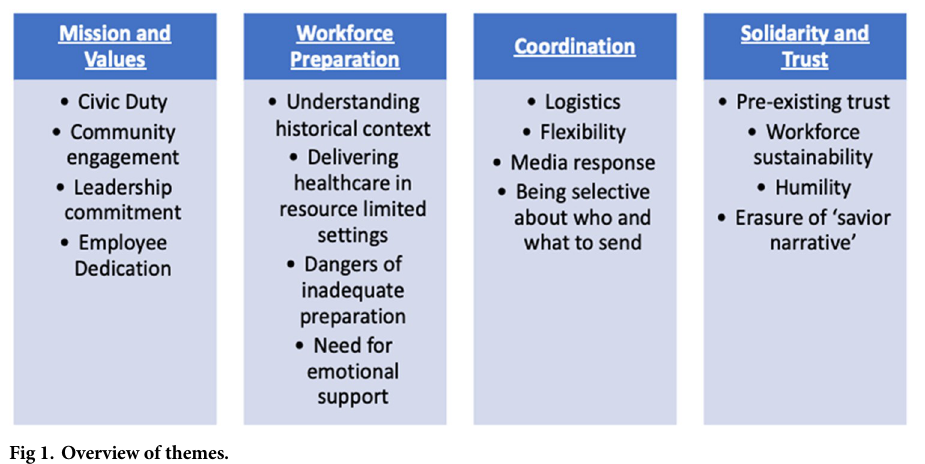
Fig 1. Overview of themes.